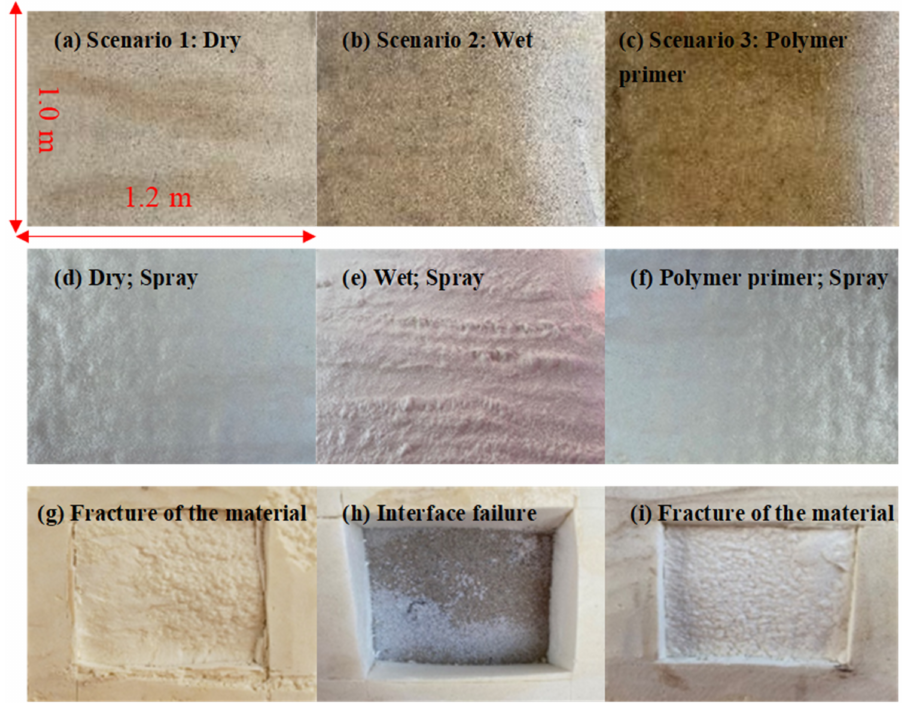
Figure 6. Three scenarios, spraying performance and adhesive strength tests under three scenarios: ( a – c ) for Scenarios 1~3; ( d , g ) for Scenario 1; ( e , h ) for Scenario 2; ( f , i ) for Scenario